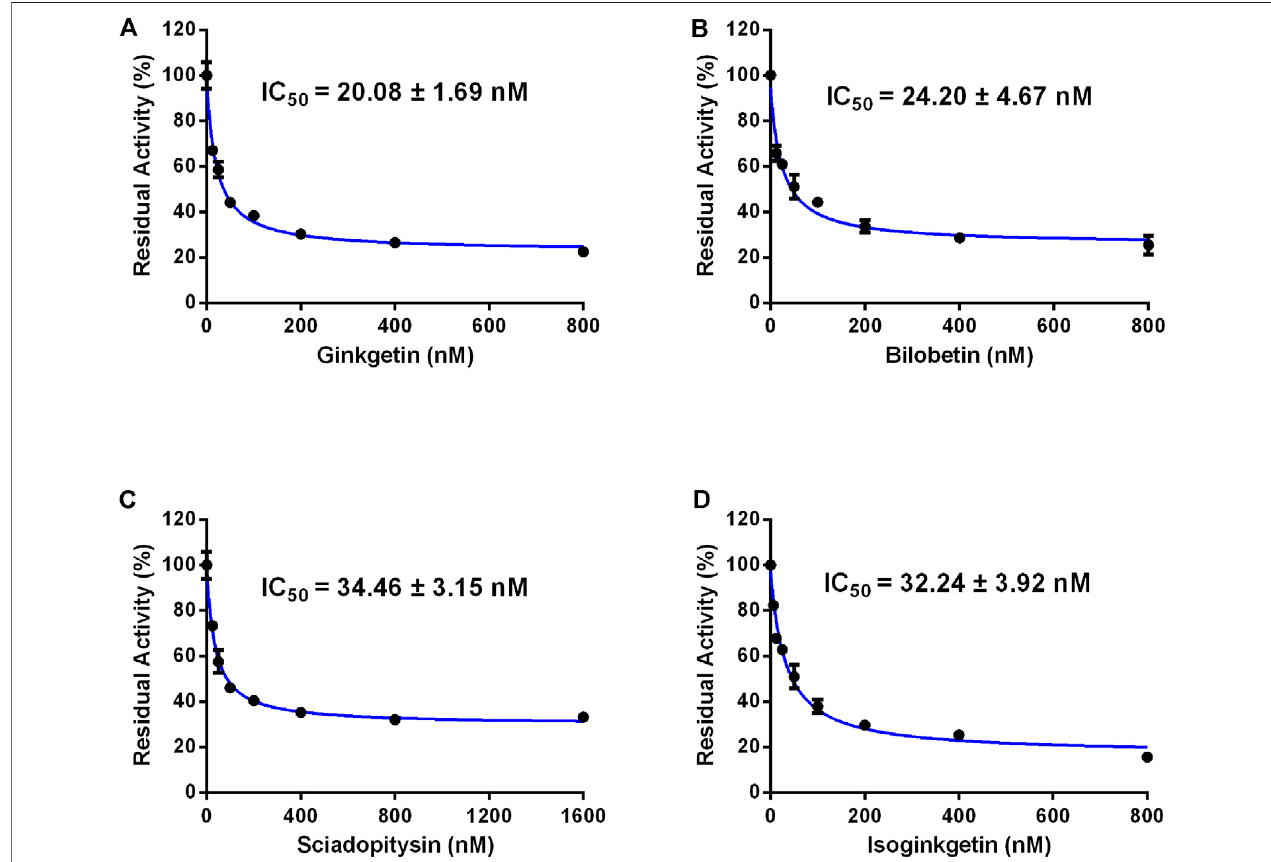
FIGURE3| Dose-inhibition curves ofginkgetin (A) , bilobetin (B) ,sciadopitysin (C) and isoginkgetin (D) on CES2 using FDastheprobe substrate in HLMs. All data were shown as mean ± SD of triplicate assays.